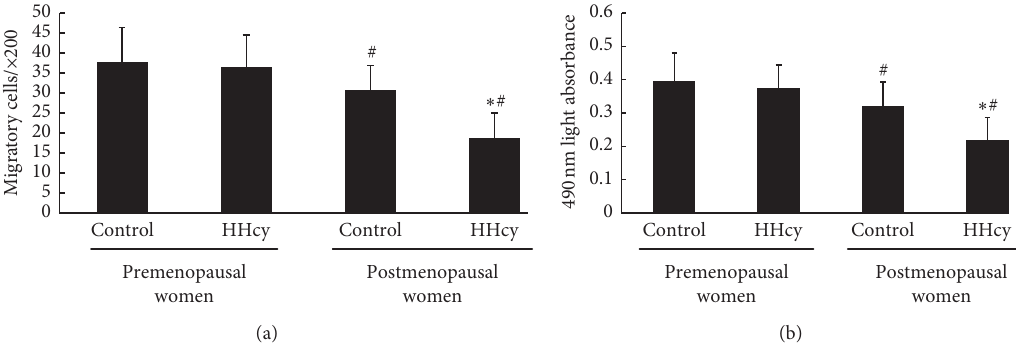
Figure 2: The activity of circulating EPCs in the four groups is shown as follows. The migratory (a) and proliferative (b) activities of circulating EPCs in postmenopausal women were lower than those in premenopausal women. There was no difference in the migratory (a) and proliferative (b) activity between control and hyperhomocysteinemia premenopausal women. Nevertheless, the EPC function in hyperhomocysteinemia postmenopausal women was lower than that in control postmenopausal Women. Data are given as mean ± SD. ☆ vs. control; # vs. premenopausal